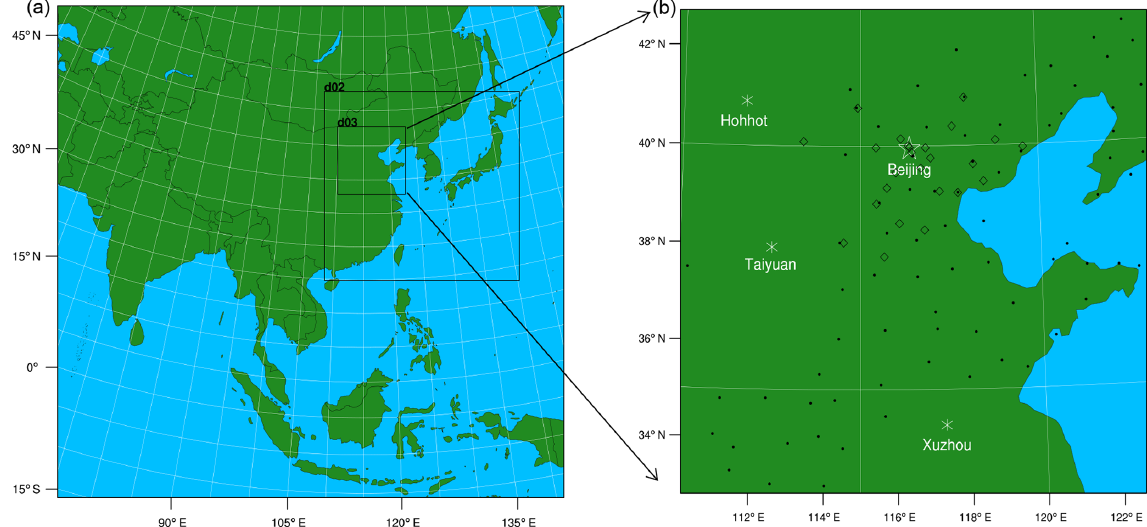
Figure 1. NU-WRF domain setup. (a) The nested MICS-Asia domains, (b) the enlarged NCP domain (d03) with diamonds representing the air quality monitoring sites and black dots denoting the meteorological stations. Locations of four cities are marked for position